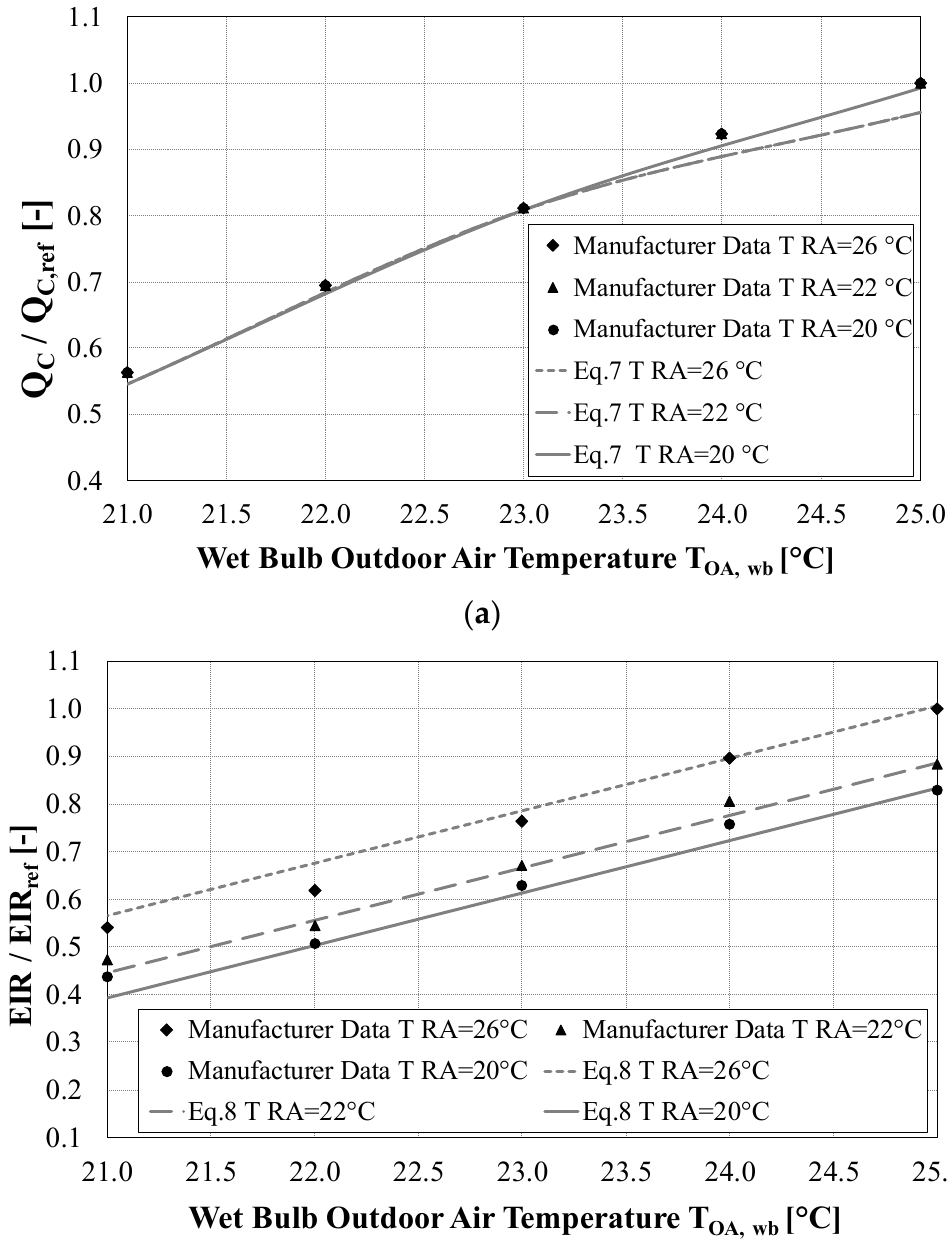
Figure 4. Cooling capacity ( a ) and HP performance ( b ) in cooling mode: comparison between Table 5 and Equations (7) and (8) with Table 7 coefficients.